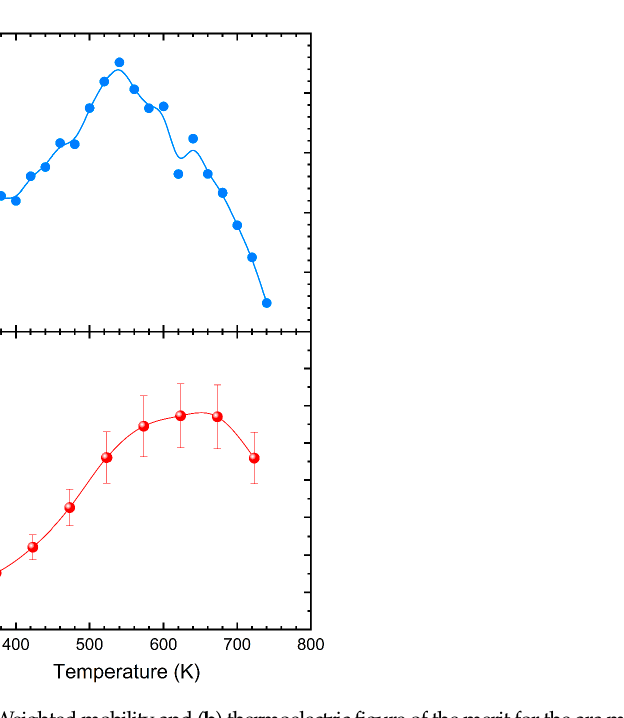
0.40.5 Figure 7. ( a ) Maximum thermoelectric figure of merit, ZT , and ( b ) minimum lattice thermal conduc- tivity for several tellurides [31,61,67,68], compared with the composition analyzed in this work, AgSbTe 2 . 0.00.10.2 0.3